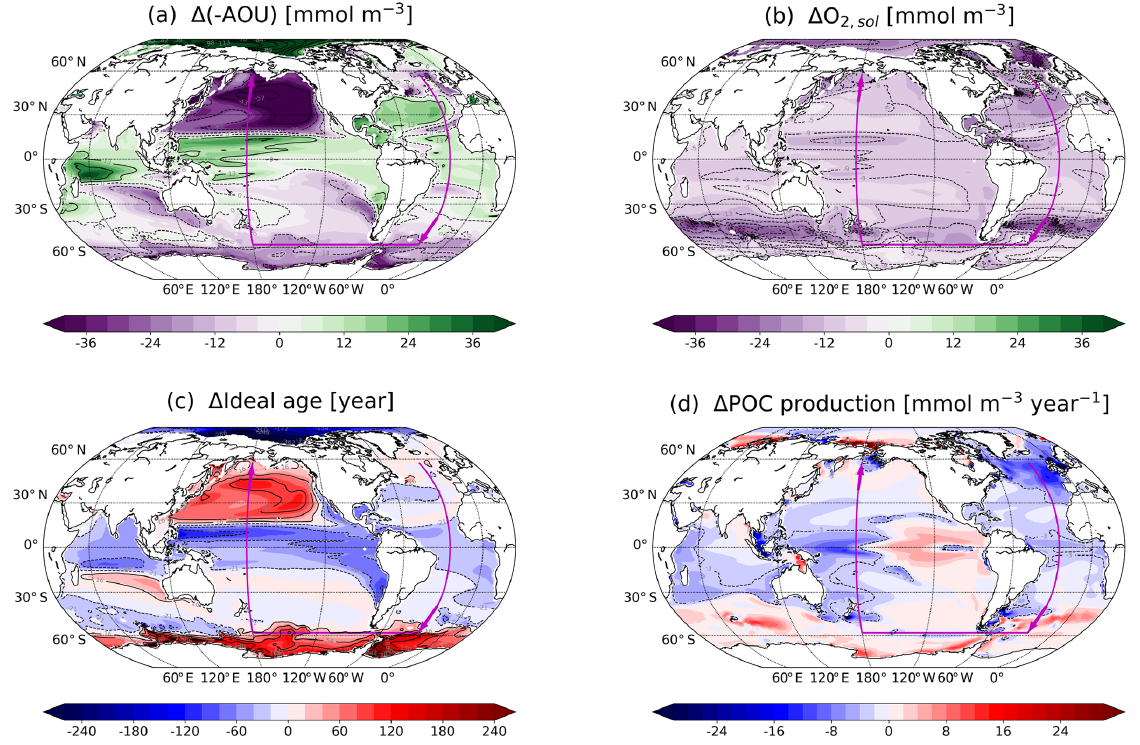
Figure 8. Anthropogenic changes ((2070–2099CE) minus (1720–1800CE)) in (a) − AOU, (b) O 2 , sol , (c) ideal age and (d) POC production. The results are averaged between 200 and 600m, except for POC production, which is averaged between the surface and 200m. The magenta arrows indicate the section path used in Fig. 9 (Atlantic: 25 ◦ W; Southern Ocean: 60 ◦ S; Pacific: 150 ◦ W).